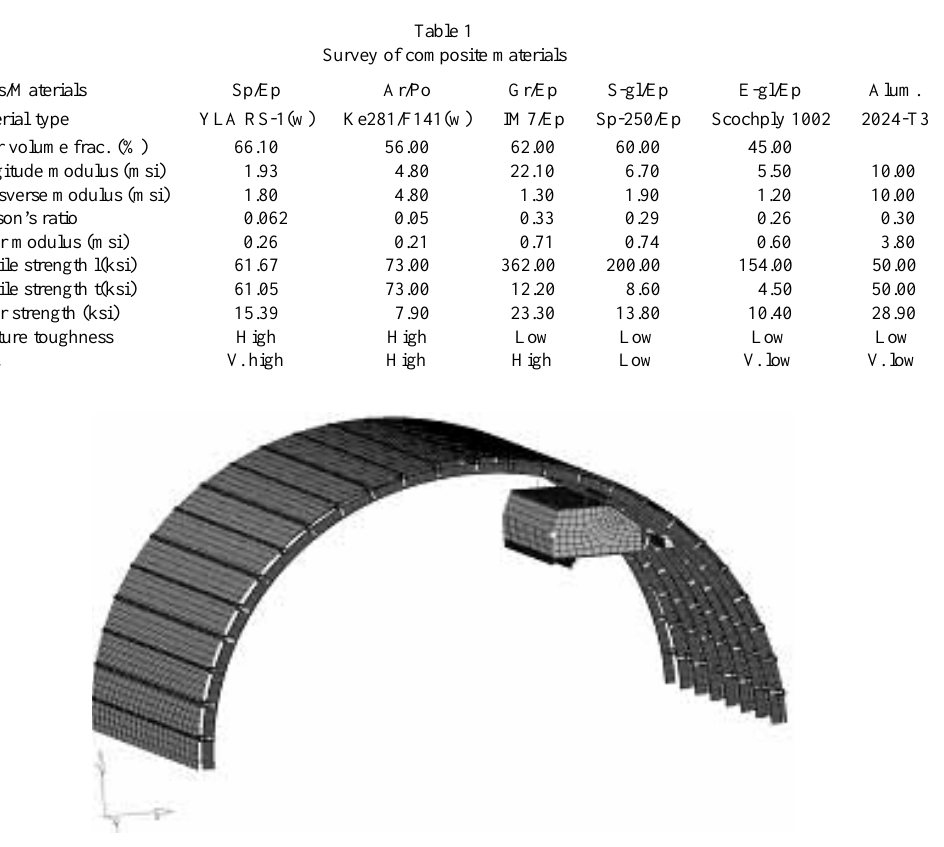
Fig. 8. Full fuselage coupled with a bin finite element